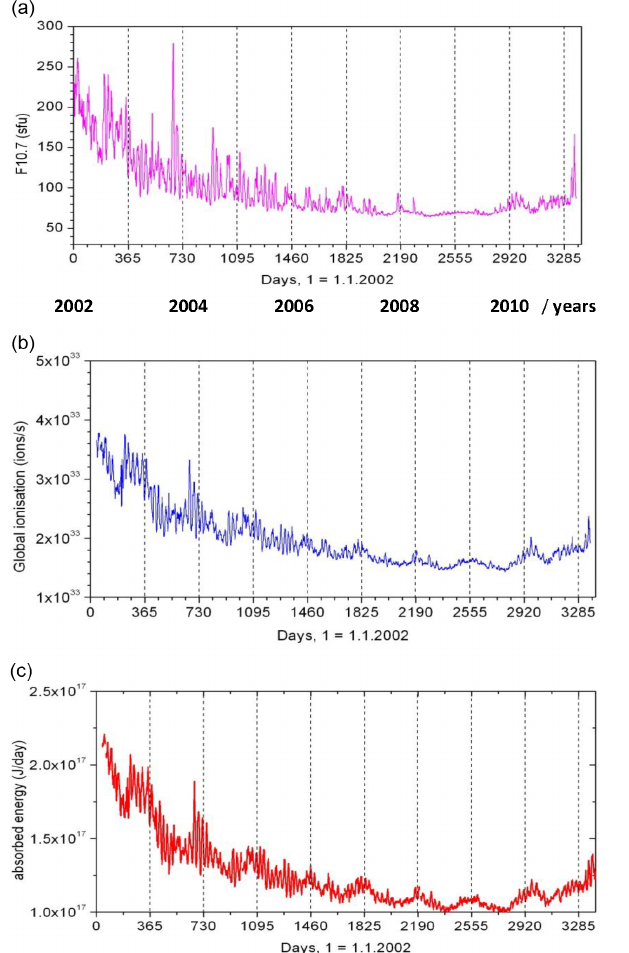
Figure 23. (a) Presentation of the F 10 . 7 index from 2002 to 2010 (Unglaub et al., 2012; copyright permission granted by Univer- sity of Leipzig). (b) Measured global total electron content from 2002–2010 (Unglaub et al., 2012; copyright permission granted by University of Leipzig). (c) EUV energy deposited in the thermo- sphere from 2002–2010 (Unglaub et al., 2012; copyright permission granted by University of